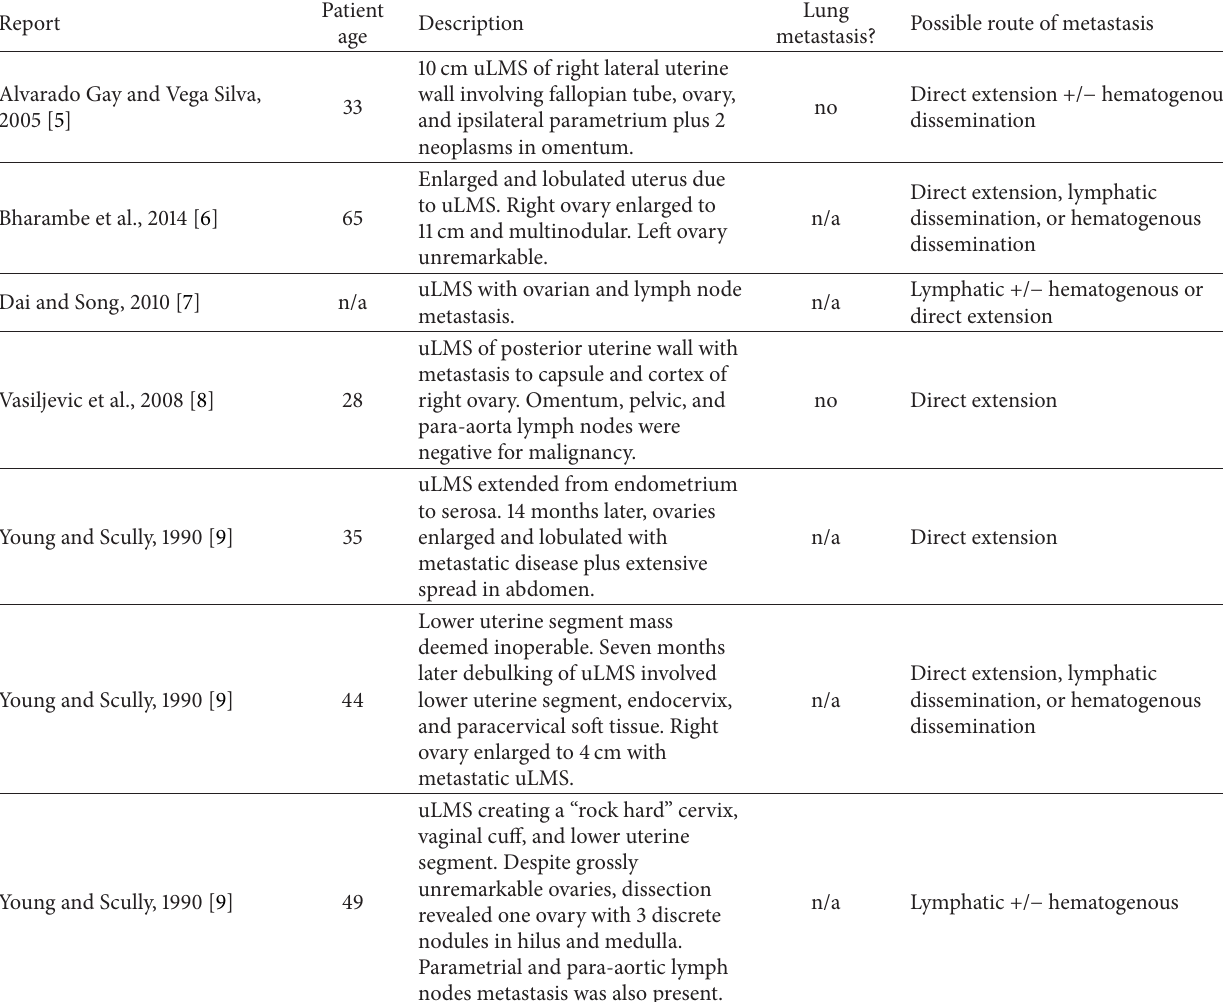
Table 1: Summary of the literature review of uLMS cases with ovarian